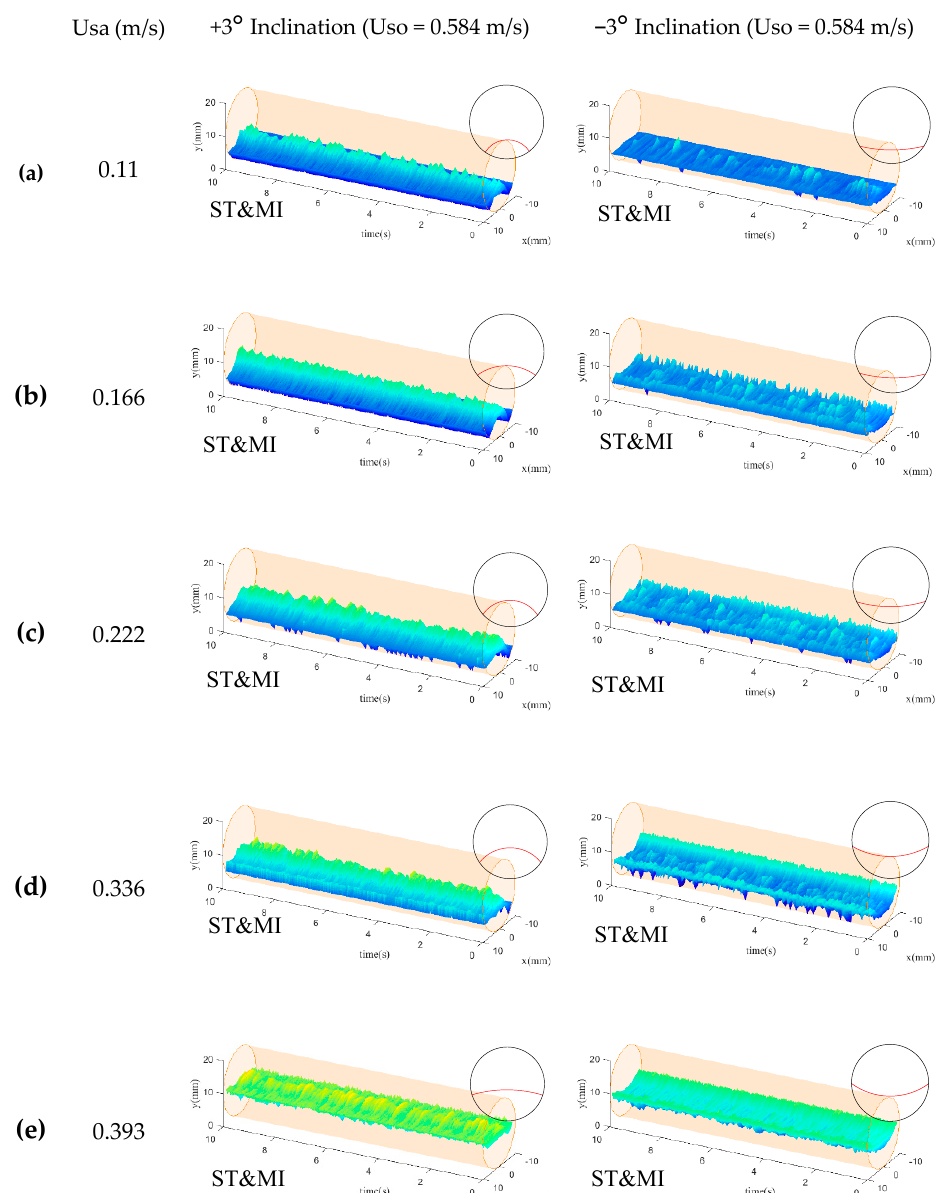
Figure 15. CPAP visualizations of the liquid-liquid interfaces for Uso = 0.584 m/s: ( a ) Usa = 0.11 m/s; ( b ) Usa = 0.166 m/s; ( c ) Usa = 0.222 m/s; ( d ) Usa = 0.336 m/s; ( e ) Usa = 0.393 m/s.